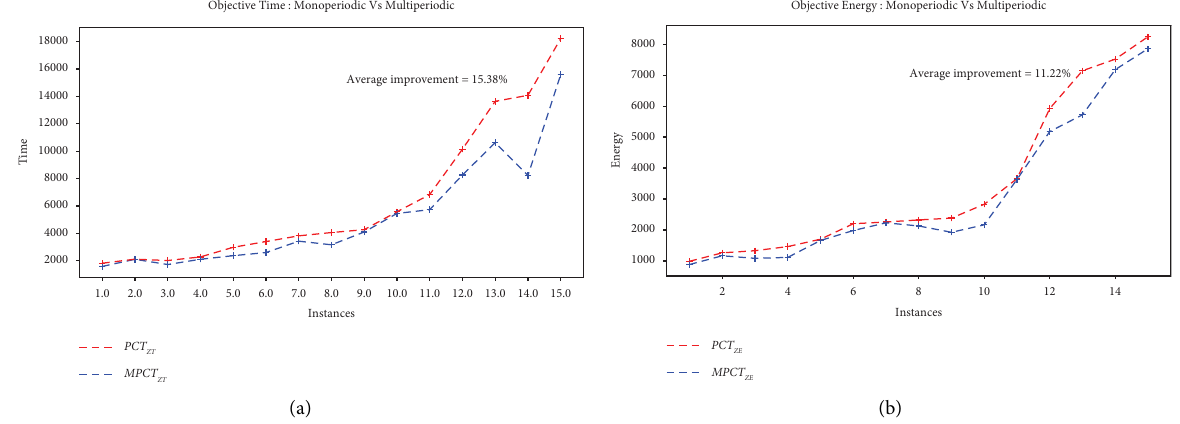
Figure 5: Results of MILP-MPCT model vs. PCTs solver [51]. (a) Time minimization. (b) Energy minimization.